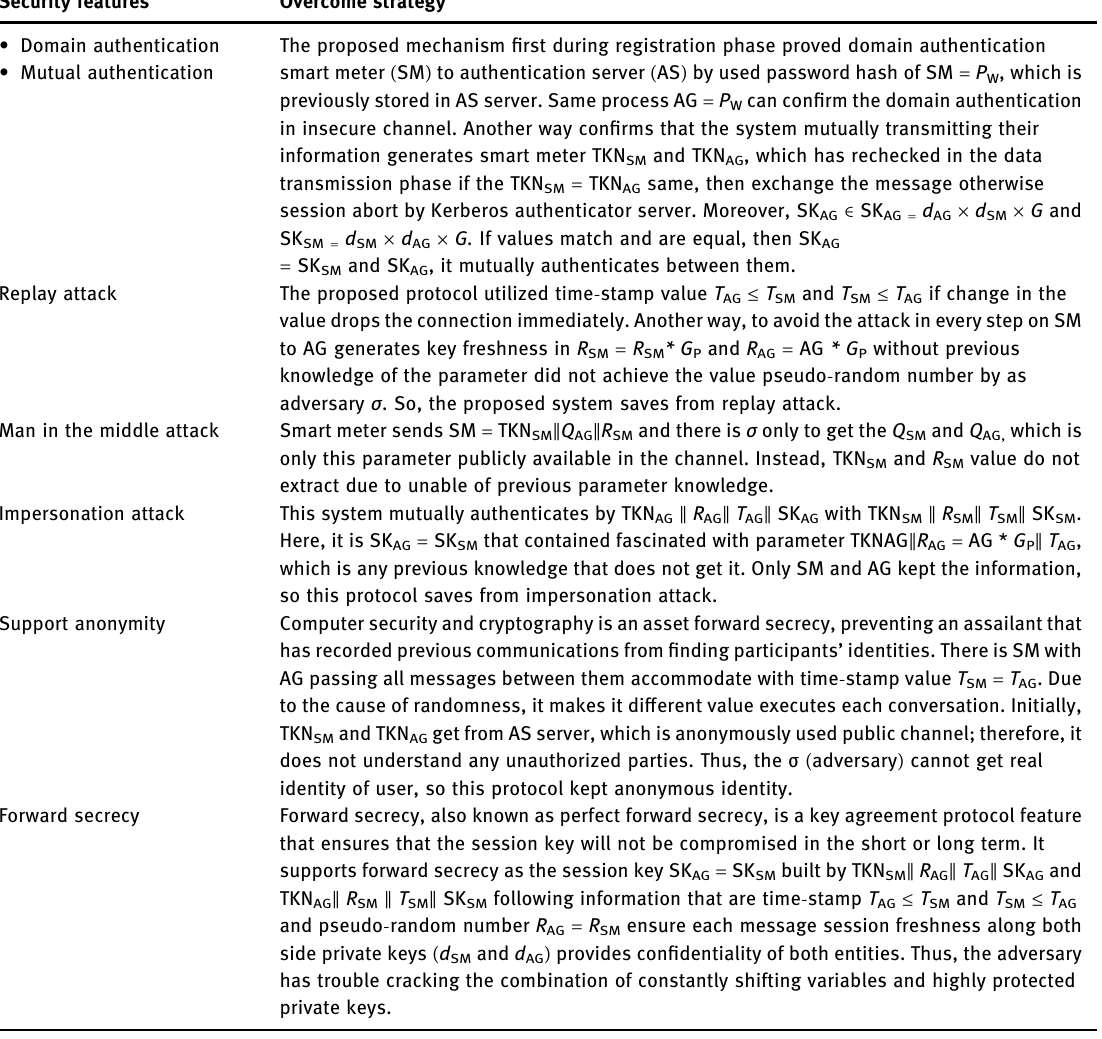
Table 4: Informal security analysis strategy Security